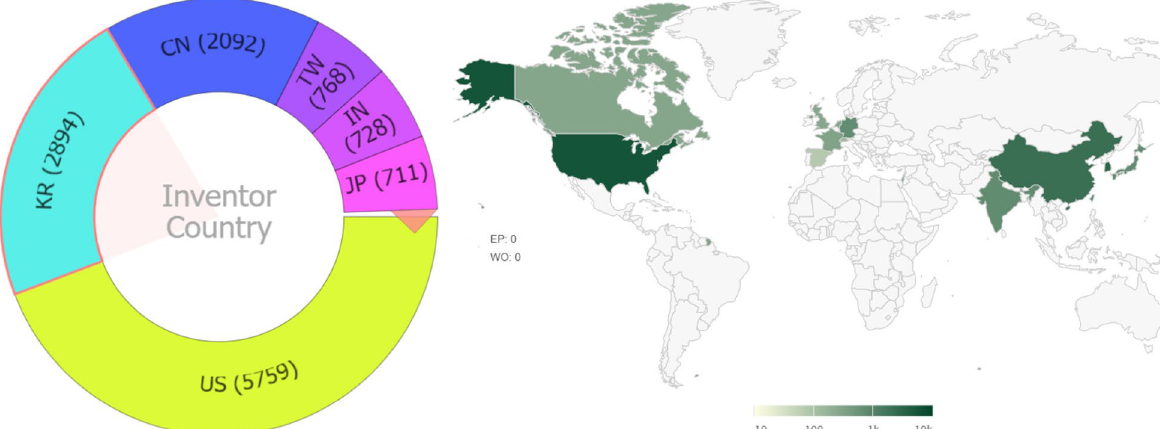
Fig. 3 Distribution of inventors by country of residence. The left chart shows the number of records by the country of residence of inventors. The right chart shows the number of records by the country where the application was filed. Note that a record is included in each unique country